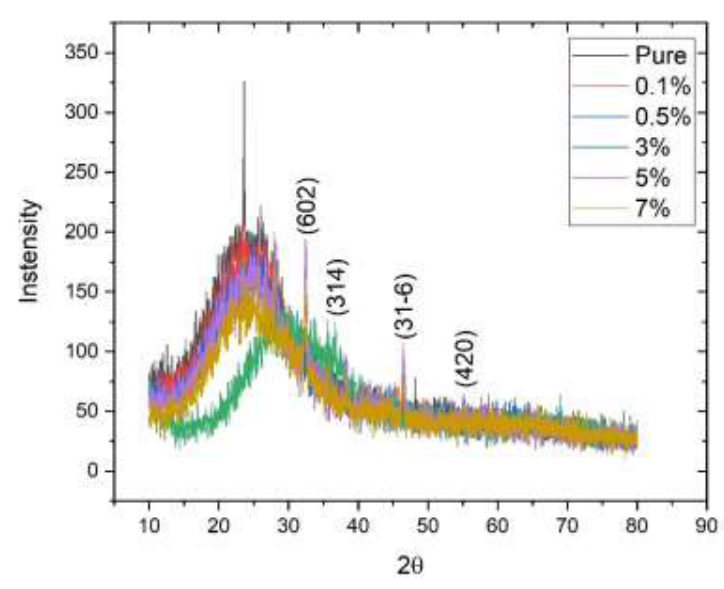
Fig. 3: X-ray diffraction pattern of PPy and PPy/Ag nanocomposites (0.1%, 0.5%, 3%, 5% and 7%